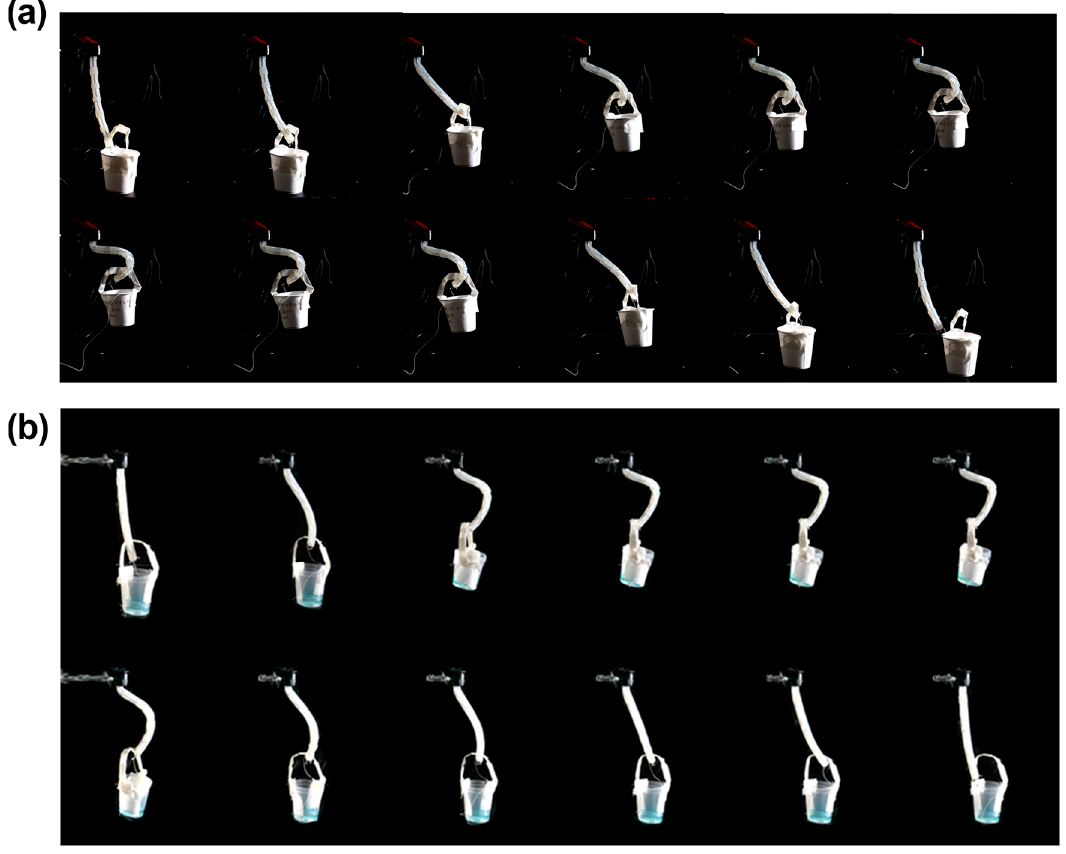
Figure 7. Lifting experiments: ( a ) Soft actuator when lifting and putting down the paper cup; and ( b ) Stably lifting and putting down a cup containing water.